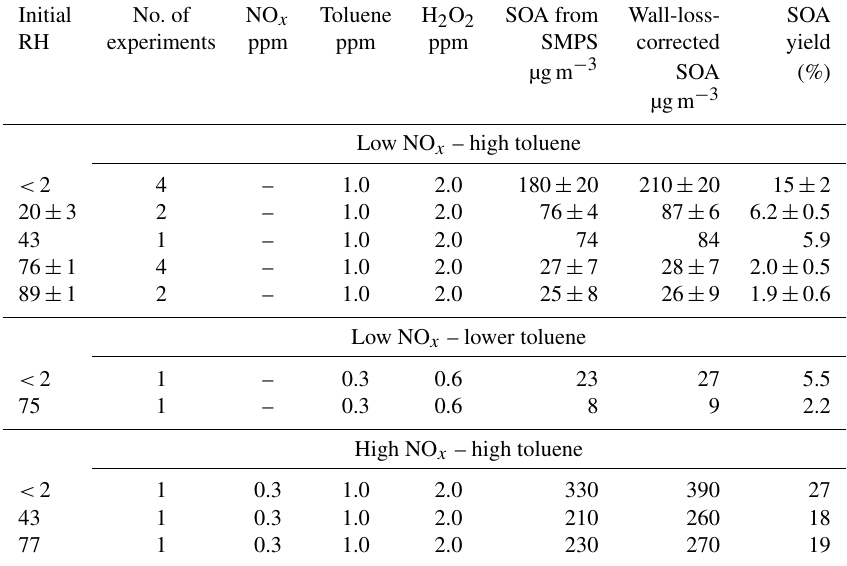
Table 2. Summary of SMPS experiments. The uncertainties included in this table are based on 1 standard deviation in the data for repeated experiments. Initial No. of NO x Toluene H 2 O 2 SOA from Wall-loss- SOA RH experiments ppm ppm ppm SMPS corrected yield µgm − 3 SOA (%) µgm − 3 Low NO x – high toluene < 2 4